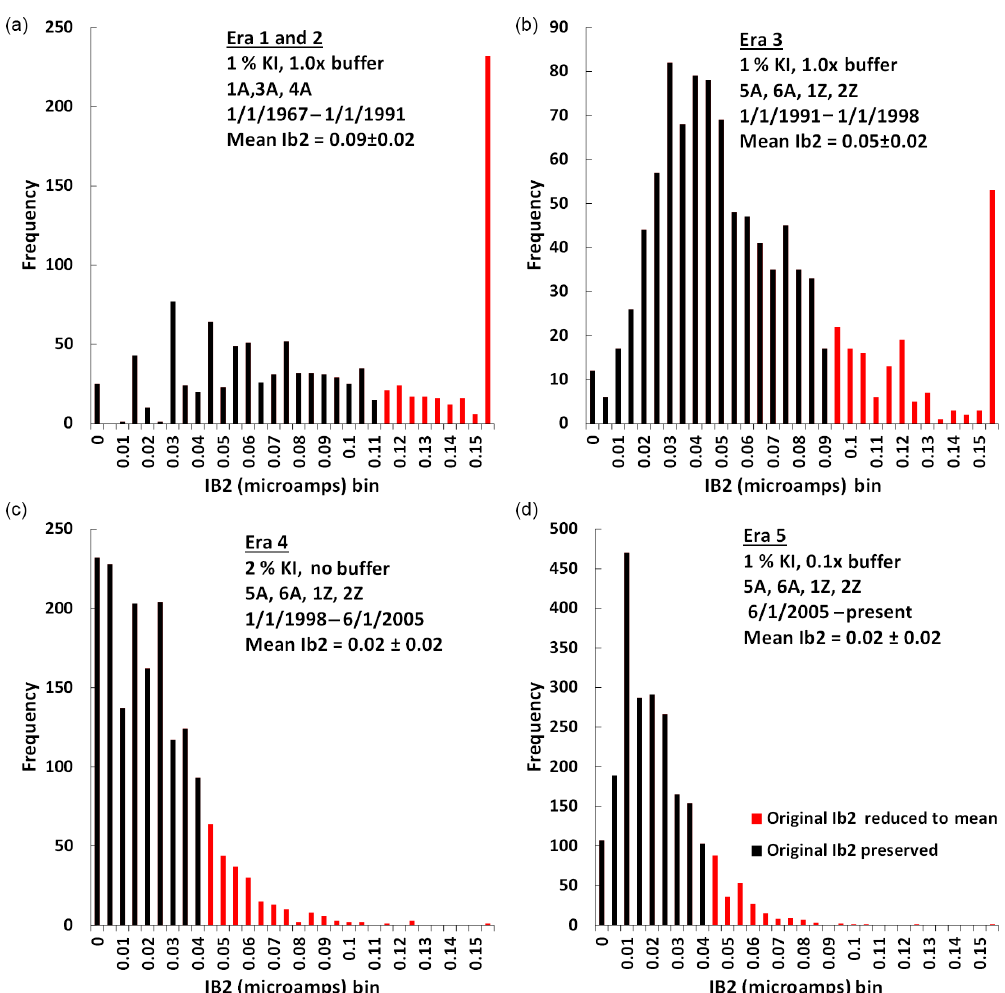
Figure 2. Histogram of all cell current backgrounds from Boulder, South Pole and Hilo broken into four time periods: (a) Eras 1 and 2, (b) Era 3, (c) Era 4, and (d) Era